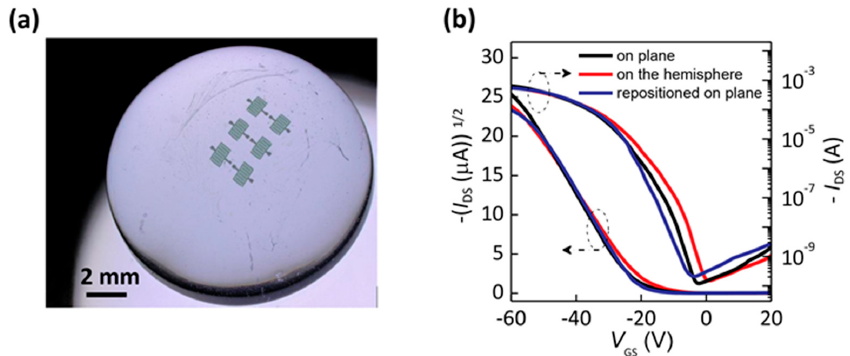
Figure 5. ( a ) 3D optical microscope image of ultrathin C8-BTBT OTFTs adhered on a glass hemisphere ( r = 6.5 mm). ( b ) Corresponding transfer characteristics of the device under three deformation states: on plane, on the glass hemisphere, repositioned on plane.